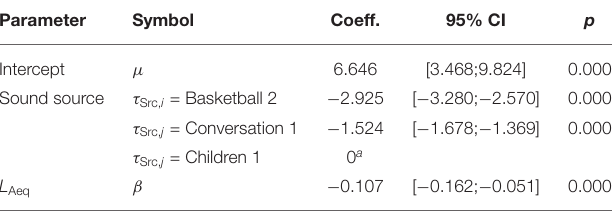
TABLE 6 | Experiment 3: model coefficients (Coeff.), their 95% CI, and probabilities ( p ) of the linear mixed-effects model for acoustic comfort. Parameter Symbol Coeff. 95% CI p Intercept